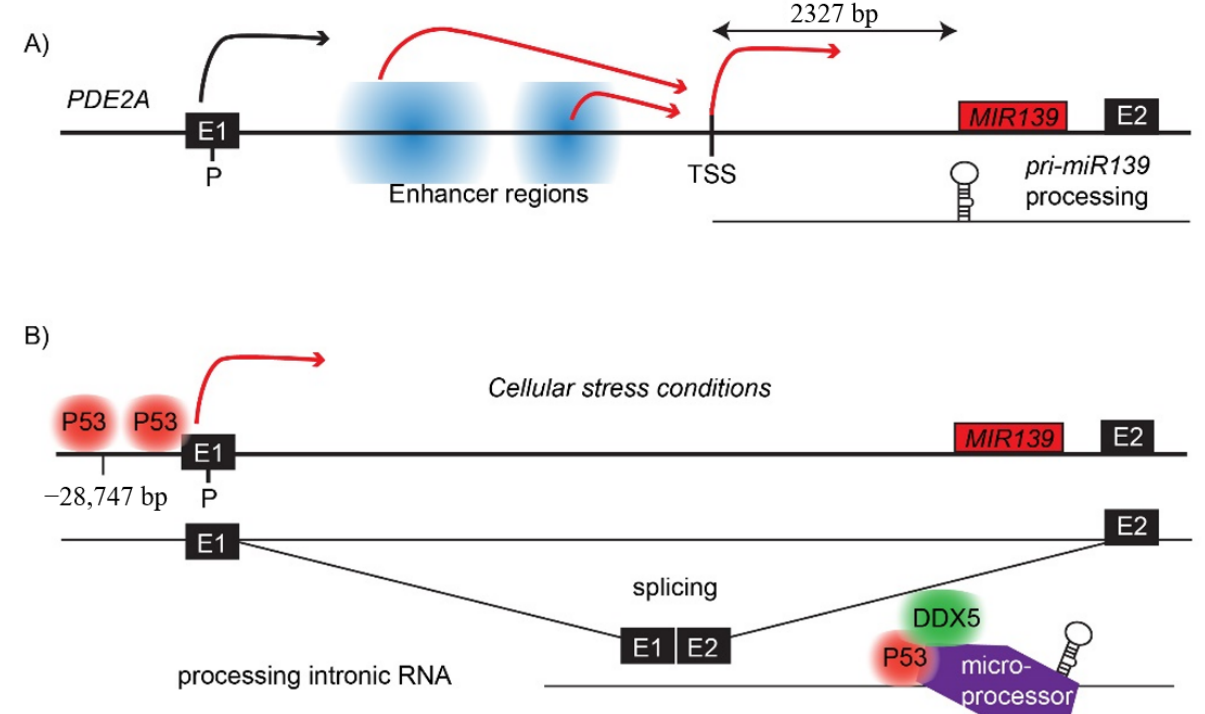
Figure 1. Overview of the transcriptional regulation of MIR139 . ( A ) Schematic representation of the PDE2A locus (chr11: 72,605,000–72,644,500) with the promoter (P), transcriptional start site of MIR139 (TSS), the first two exons of PDE2A (E1 and E2), enhancer regions (in blue) and MIR139 (red box). The transcription of PDE2A is indicated by the black arrow. The enhancer regions are critical for MIR139 transcription (red arrows). ( B ) Schematic overview of the model in which, under cellular stress conditions, p53 binds to the PDE2A promoter and stimulates transcription (red arrow) and processing of pri-miR-139 .